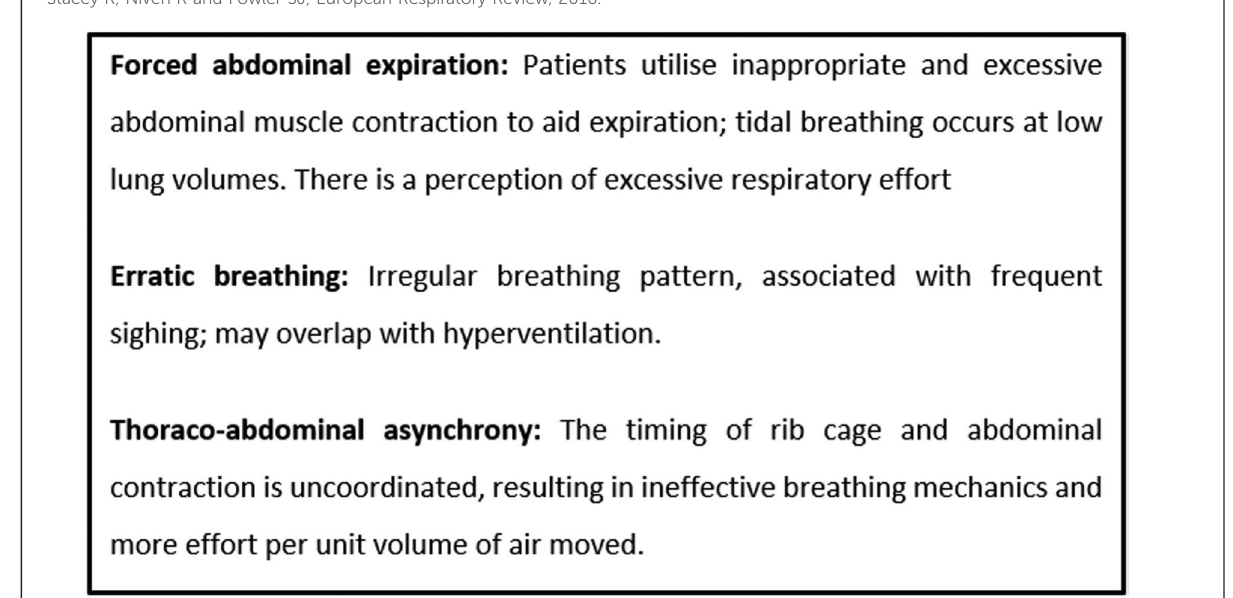
BOX1 | Three subtypes of dysfunctional breathing that may be mistaken for dyspnoea arising from asthma. Proposed nomenclature by Boulding R, Stacey R, Niven R and Fowler SJ, European Respiratory Review,